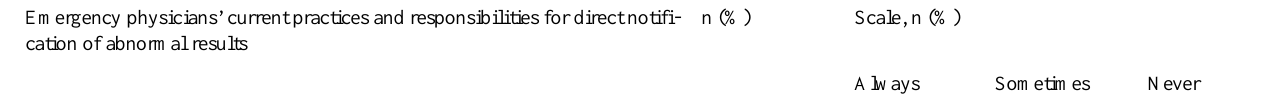
Table 4. Emergency physicians’current practices and responsibilities for direct notification of abnormal results.